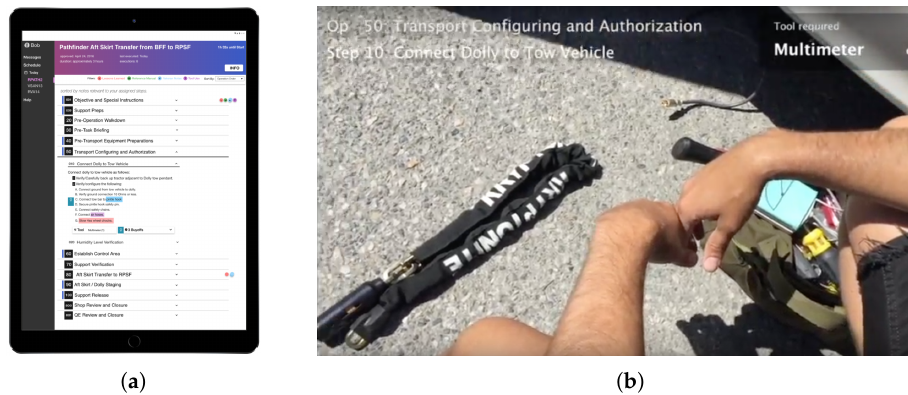
Figure 4. ( a ) iPad Interface. ( b ) Proof-of-concept for heads-up display.